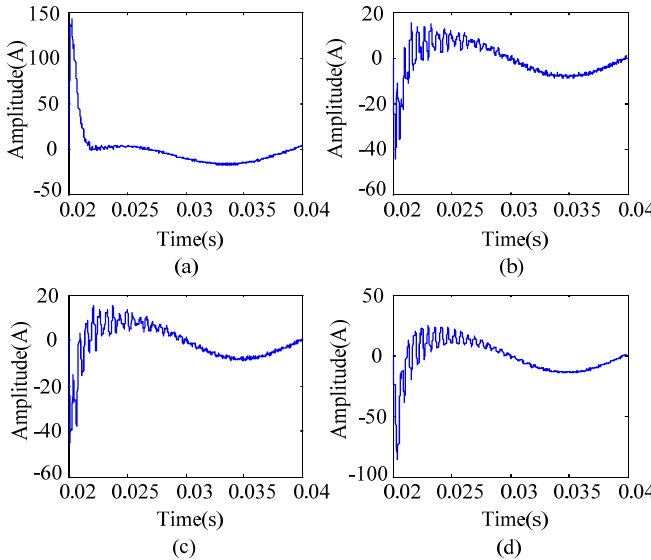
Figure 7. TZSCs for SPG fault. ( a ) Lian L 1 ; ( b ) Lian L 2 ; ( c ) Lian L 3 ; ( d ) Lian L 4 .